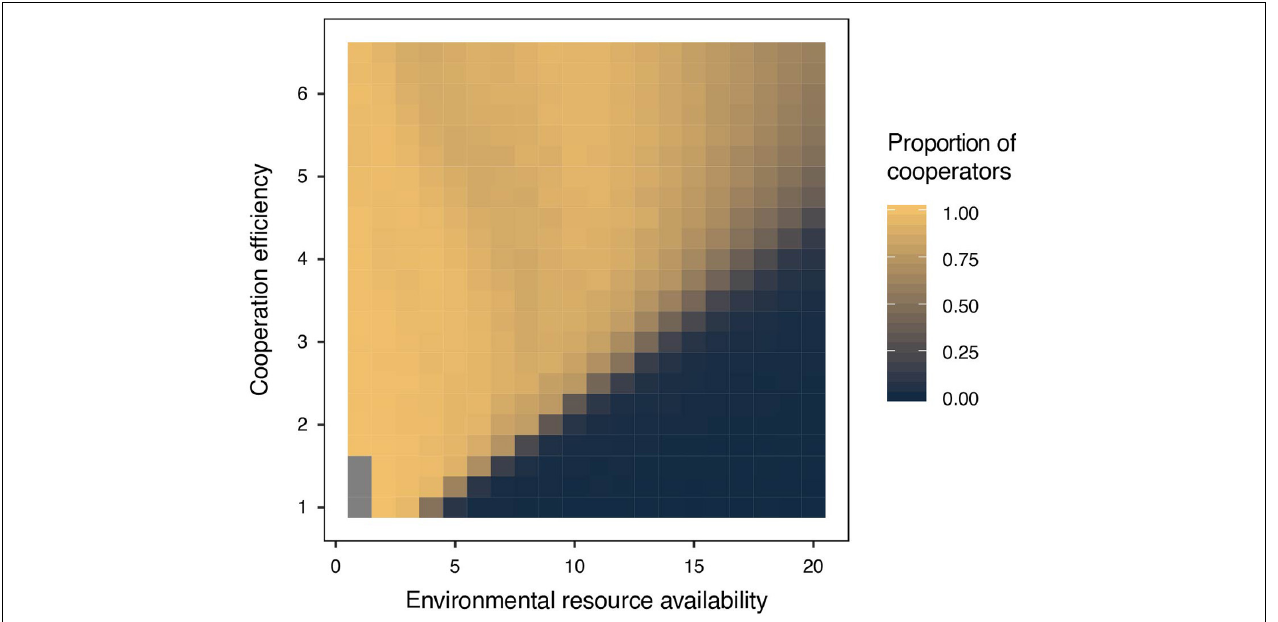
FIGURE 2 | The proportion of cooperators in populations in relation to environmental resource availability and cooperation efficiency. Intraspecific cooperative behavior is more likely to evolve when environmental conditions are harsh (i.e., low environmental resource availability) and when cooperation efficiency, an intrinsic property of individuals, is